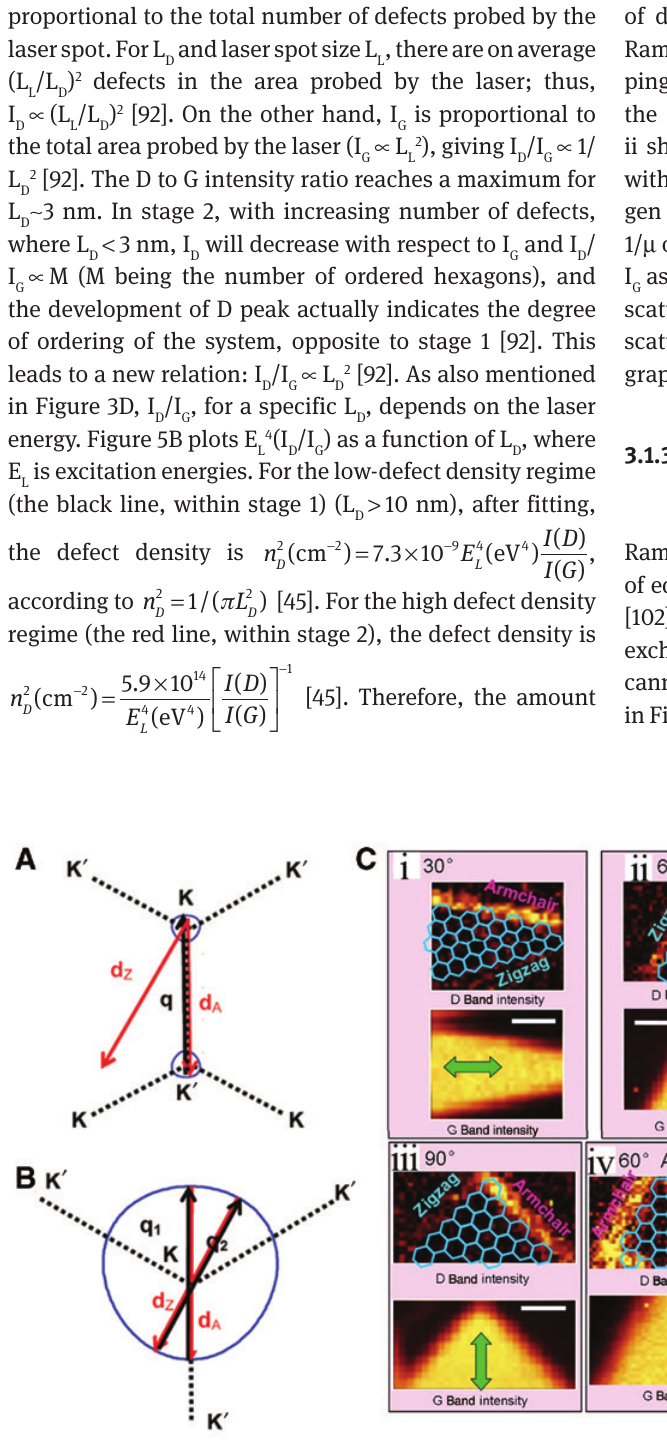
Figure 6: (A) Schematic of intervalley process: only the exchanged momentum from armchair edges d of intravalley process: both the exchanged momentum from armchair and zigzag edges, d same region around K (K ′ ). Reprinted with permission from [102]. Copyright 2009 American Chemical Society. The blue line is an iso-energy contour, taking into account the trigonal warping. (C) Raman images from graphene edges with angles (i) 30 ° , (ii) 60 ° (zigzag), (iii) 90 ° , and (iv) 60 ° (armchair). Reprinted from [70], with the permission of AIP Publishing. (D) (i) D peak intensity images for two coalesced graphene grains with a single GB. (ii) Representative room-temperature I-V curves measured within each graphene grain (V grain boundary (V ). Reprinted with permission from [103]. Copyright 2011 Nature Publishing 8,9